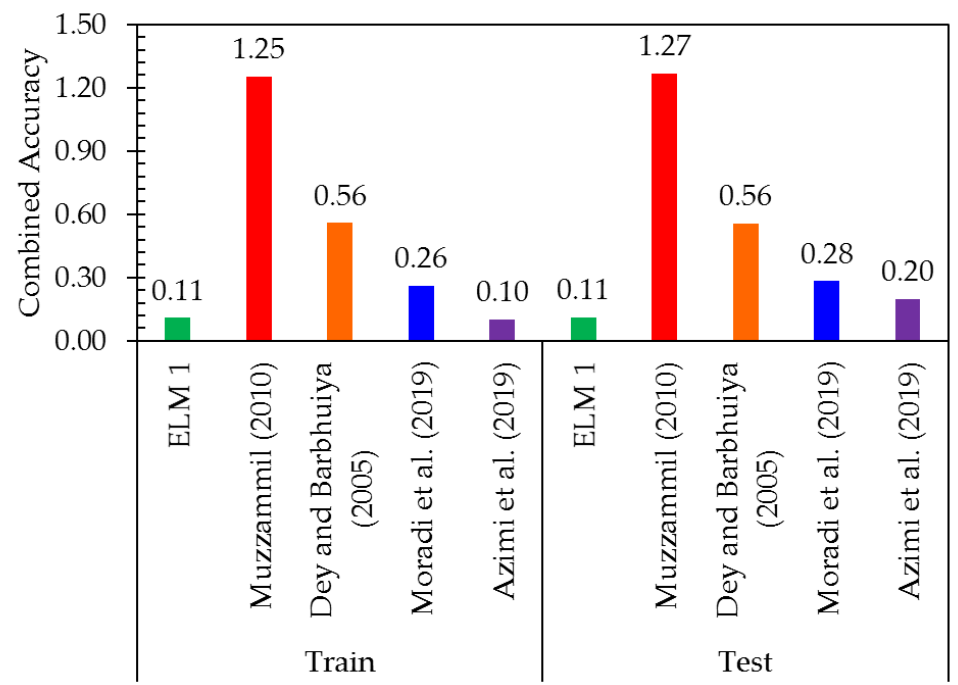
Figure 7. Comparison of the developed ELM model for abutment scour depth prediction with existing conventional and artificial intelligence (AI)-based techniques by combined accuracy ( CA ) index.